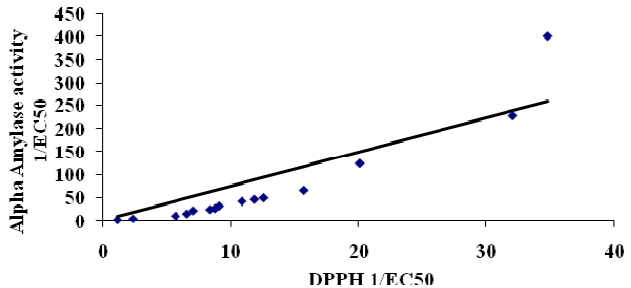
Figure 3. Correlation between  -amylase assay (antihyperglycemic) and DPPH assay (antioxidant). Correlation = 0.9469.